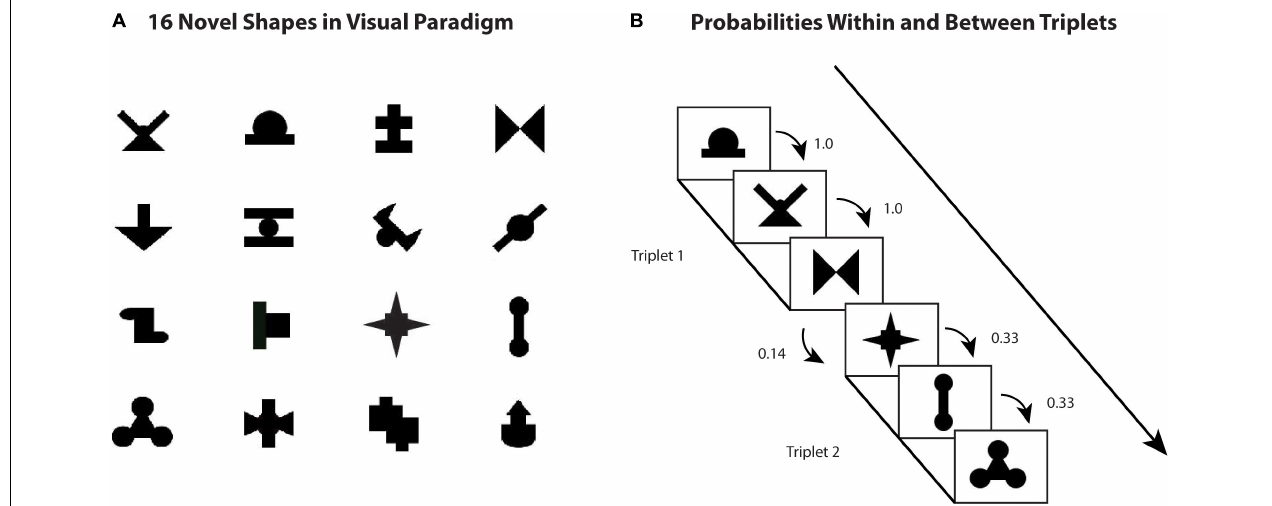
FIGURE 1 | Visual statistical learning task figures (A) 16 novel shapes used in visual paradigm (B) example of probabilities within and between